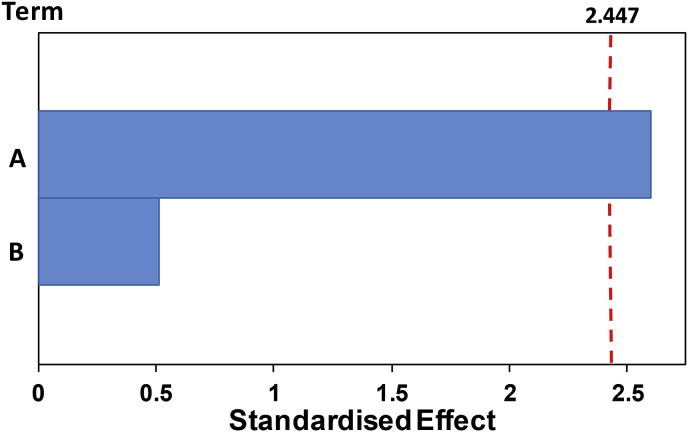
Pareto chart for power (α = 0.05) where the temperature is defined as term A whereas the ramp time is defined as term B.